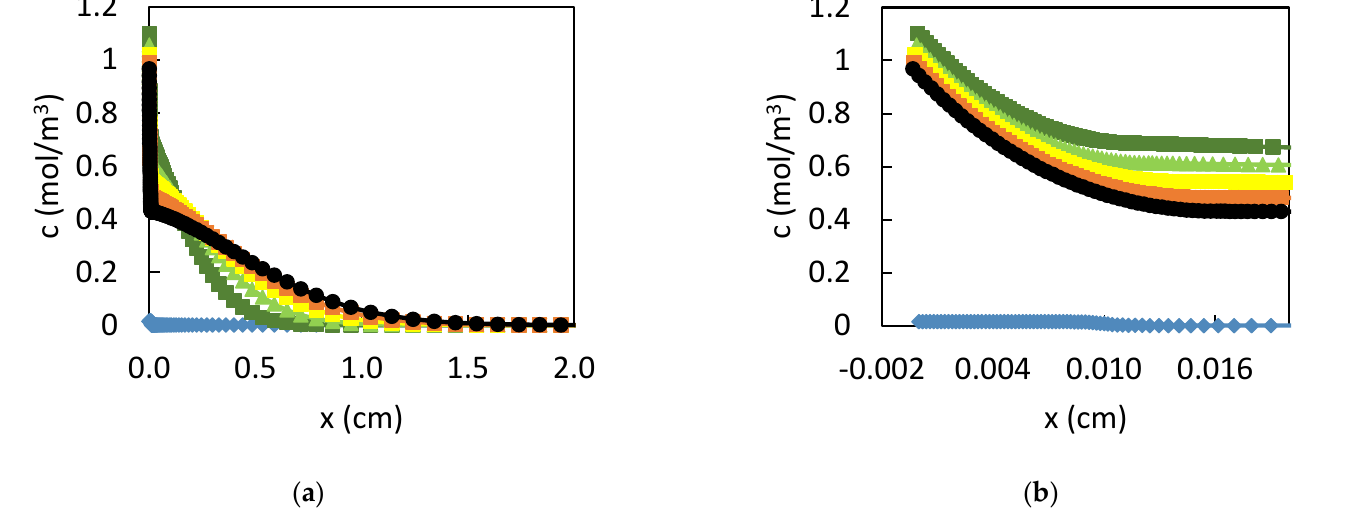
Figure 8. Evolution of the lead ion concentration in an electrolyte of 1000 mol/m 3 HCl and of size L = 10 cm with an initial CPL of 100 µm and a fixed porosity of 0.9 ( a ) The first 2 cm and ( b ) the first 200 µm of the electrolyte are presented for different times t = 0 (light blue), 3600 (dark green) 7200s (green), 10,800 s (yellow), 14,400 s (orange), and 18,000 s (black). The curves in blue of Figure 7 present the evolution of the size of the CPL by plotting the position of the surface x s and of the interface L0 with x L0 as a function of time. The electrode surface follows the same evolution due to the dissolution. The presence of the corrosion product layer slows the dissolution with a rate of 5629.2 µ m/yr. On the other hand, the size of PbCl 2 increases, which leads to a movement of the position of L0 to bigger values with a position at x L0 = 150 µ m after 18,000 s. The growth is linear, with an unrealistic growth rate greater than 100,000 µ m/yr. This value is non-realistic and shows the fact that in real life, the corrosion product layer does not have a fixed porosity but can become denser over